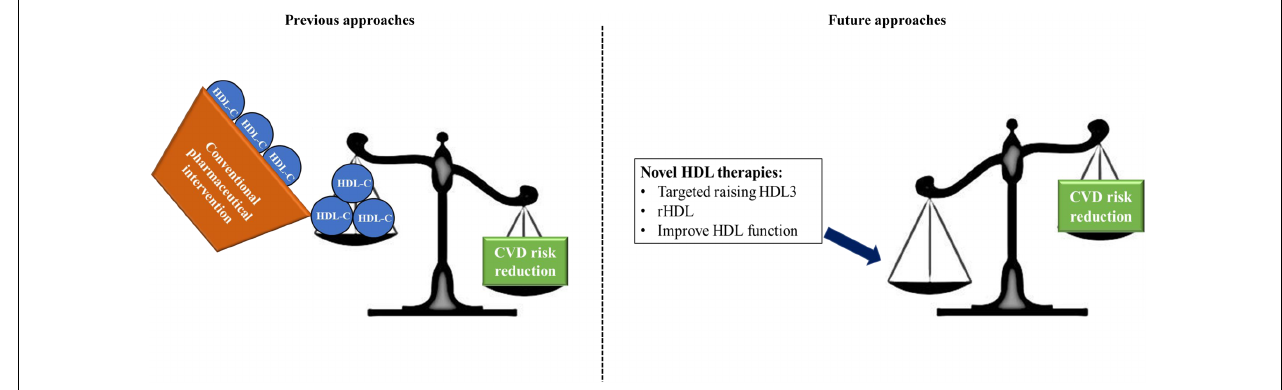
FIGURE 2 | Summary of our current findings. Previous approaches which aimed to improve CVD risk focussed on pharmaceutical increases of HDL-C concentrations. These approaches have largely been met with failure due in part to the inherent complexity of the HDL particle which displays diverse function and heterogeneity. We propose that future approaches should focus on targeted increases in HDL3, which we suggest as the functionally superior HDL subclass; using reconstituted HDL, containing increased concentrations of protective apoAI and S1P; and overall a focus on improvement of HDL function without necessarily raising